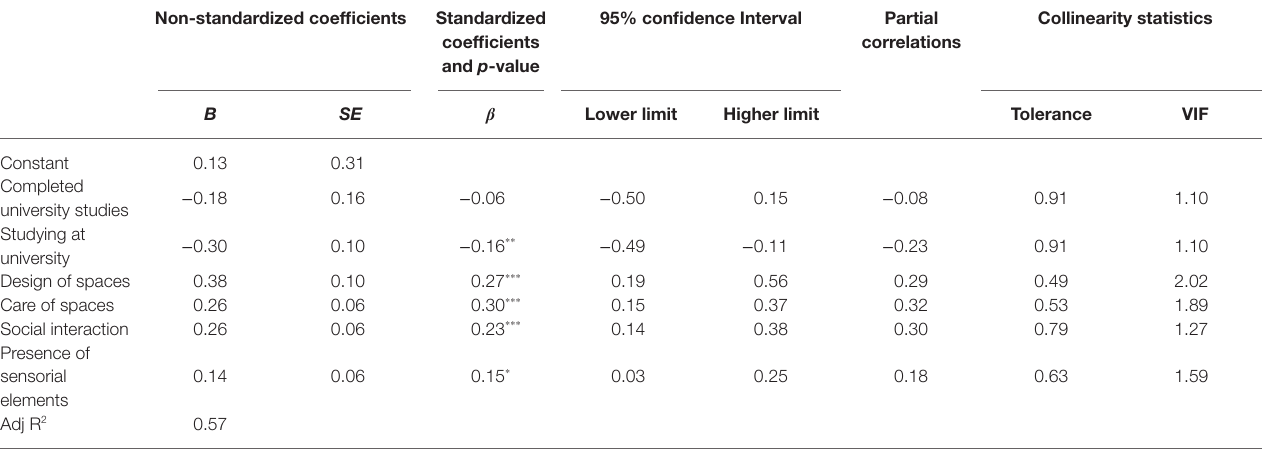
TABLE 8 | Output of the perceived environmental quality regression on perceived